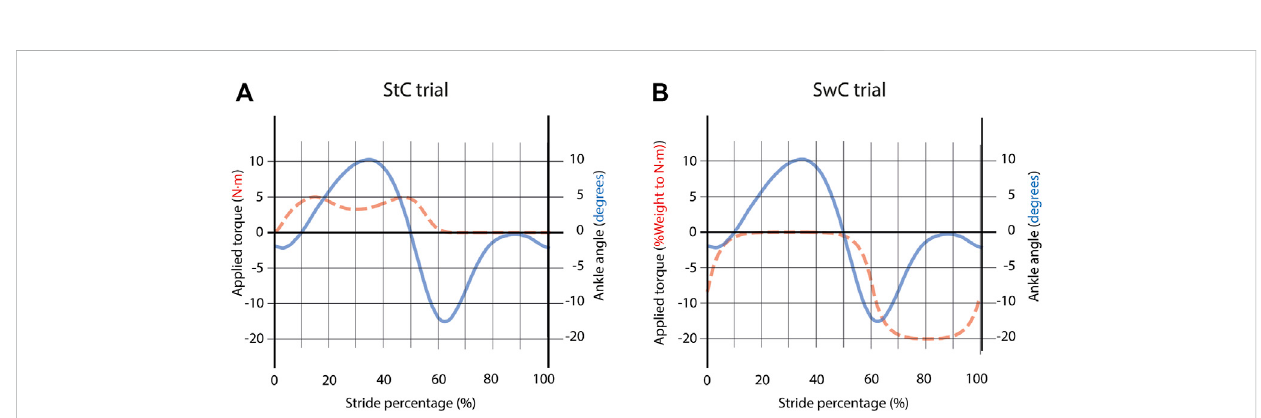
FIGURE 3 (A) Torquepro fi leandtrajectorytofollowforStCtrials.Dorsi fl exiontorque(disturbanceinupwarddirection)hadtheshapeofgroundreactionforce to mimic thistorque during StC. (B) Torque pro fi le and trajectory to follow for SwC trials. As there isno ground reaction force during swing in normal gait (foot is not in touch with the ground), a plantar fl exion torque (disturbance in downward direction) proportional to the weight of the subject was applied during SwC. (StC — Stance Correlate disturbance. SwC — Swing Correlate